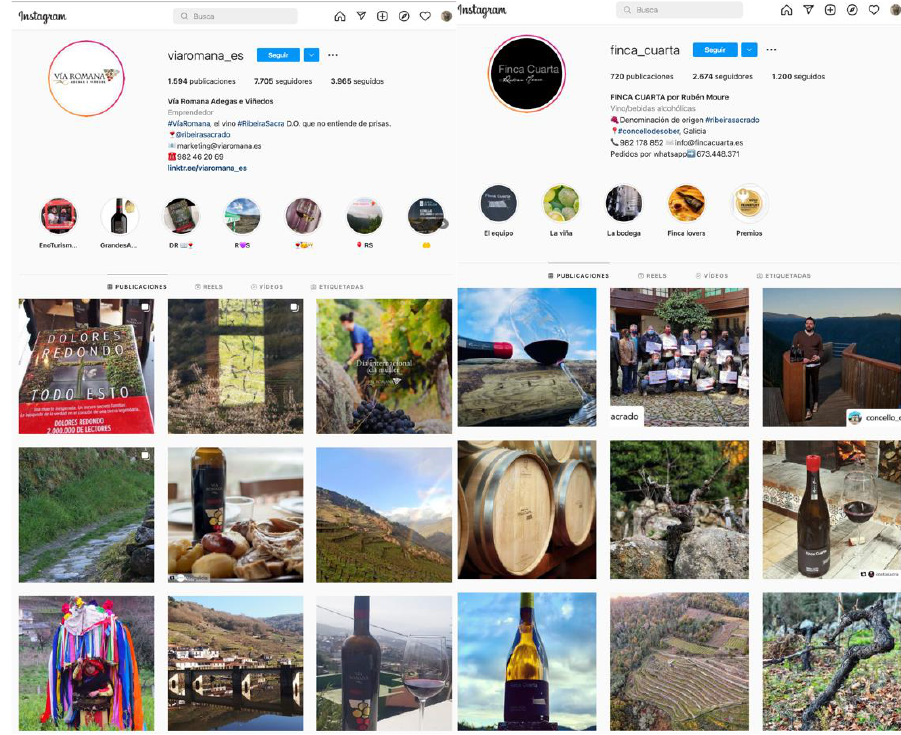
Figure 7. Instagram profiles of the Ribeira Sacra AO. Source: Own elaboration.